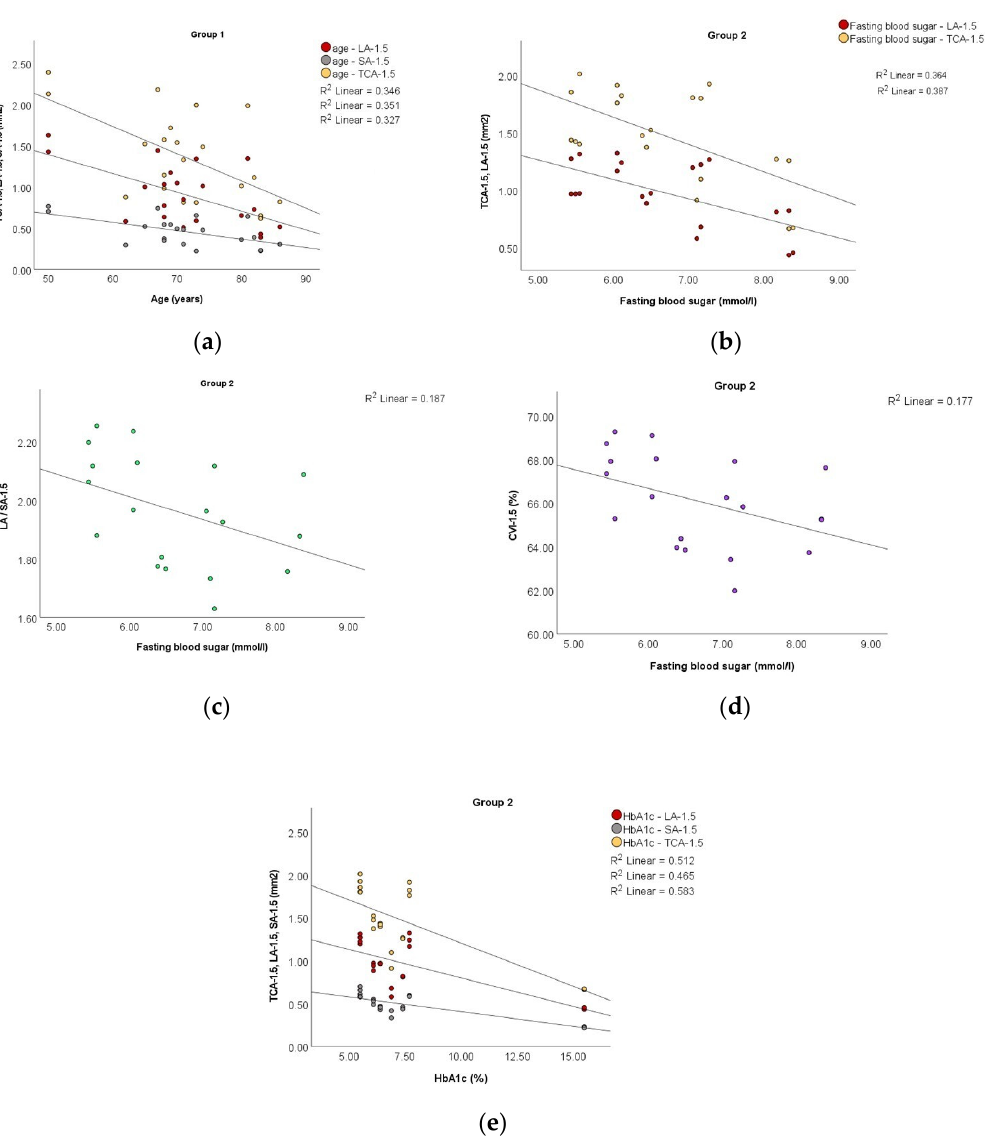
Figure 4. Scatter plots to demonstrate the correlation of: ( a ) TCA-1.5, LA-1.5 and SA-1.5 with age